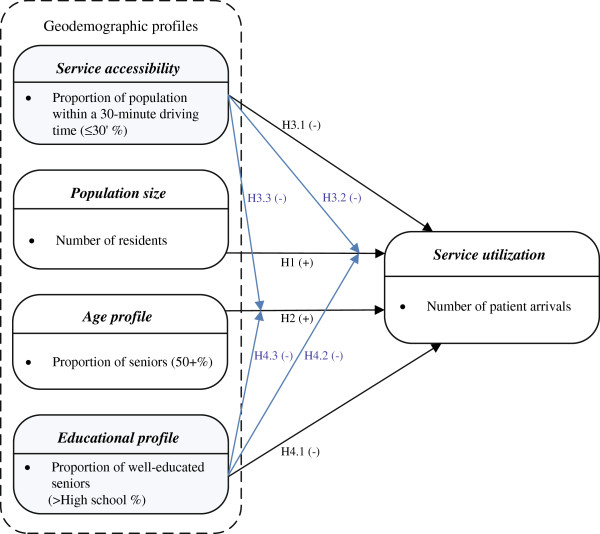
Research model for this study. The geodemographic profiles population size and age profile are positively related to service utilization. Service accessibility and educational profile are negatively related to service utilization, and negatively moderate the population size-service utilization and age profile-service utilization relationships.